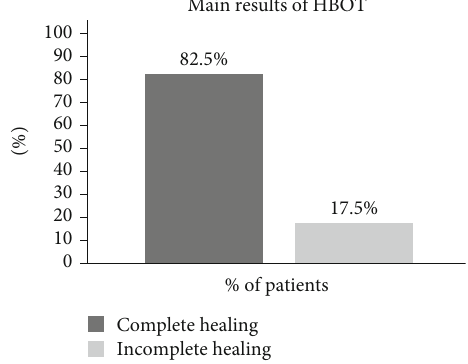
Figure 1: Main results of HBOT in 40